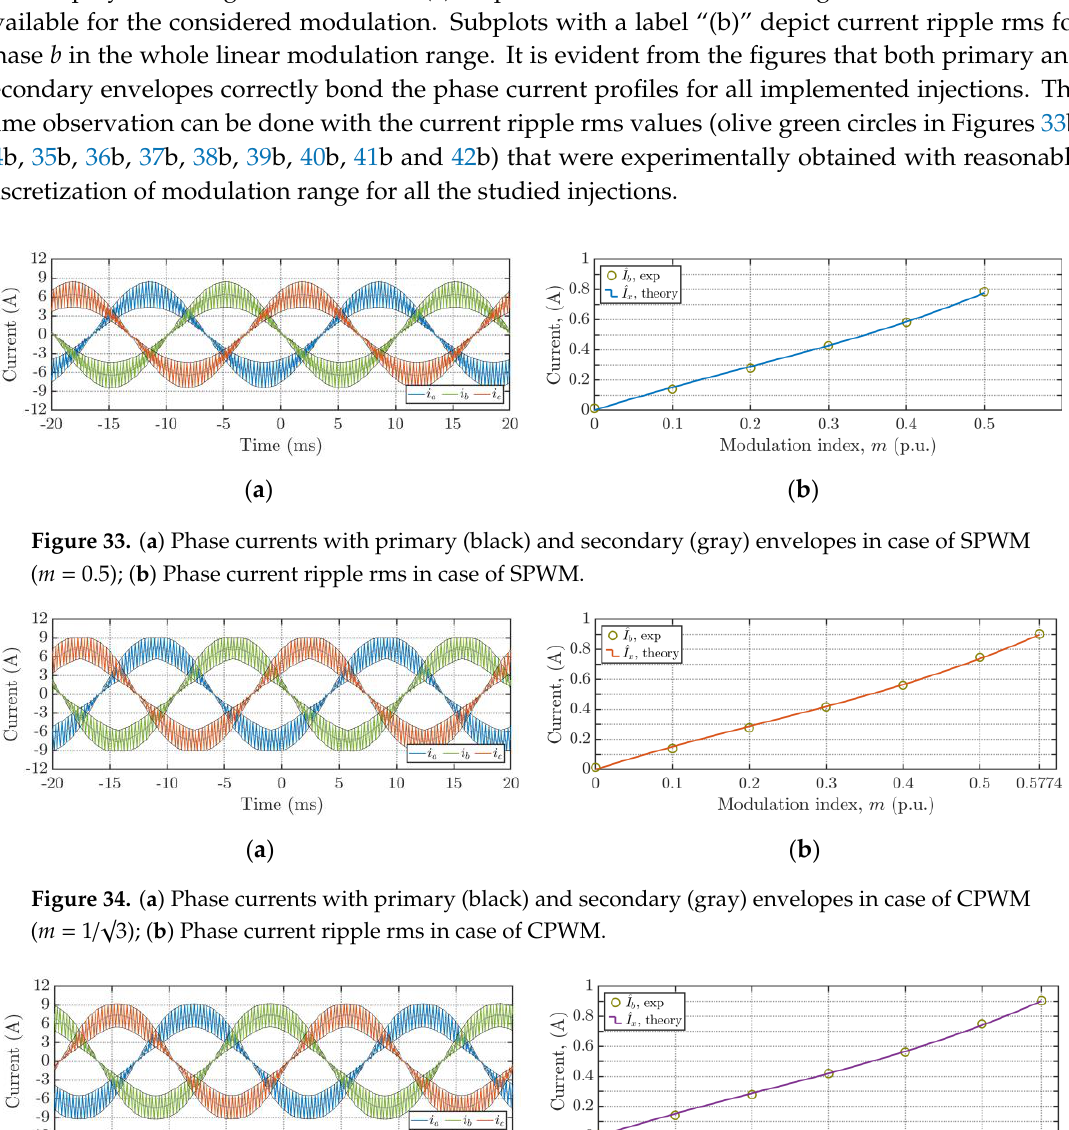
Figure 36. ( a ) Phase currents with primary (black) and secondary (gray) envelopes in case of THIPWM1/4 ( m = 6√3/(7√7)); ( b ) Phase current ripple rms in case of THIPWM1/4.